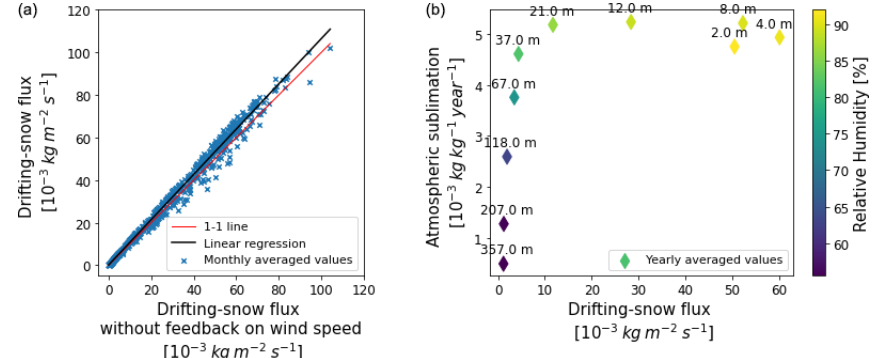
Figure 7. (a) Comparison between drifting-snow fluxes in the atmosphere calculated in MAR-DR using the usual wind speed values ( y axis) or using wind speed values retrieved from the MAR-nDR simulation ( x axis). The latter is done to approximate drifting-snow fluxes without accounting for the impact of drifting-snow sublimation on wind speeds. All fluxes are monthly averaged values over the 2010–2018 period computed at each of the 10 lowest model vertical levels. The black line denotes the best linear regression. Taking into account the atmospheric sublimation feedback on wind speed enhances drifting-snow fluxes. (b) Atmospheric sublimation as a function of drifting-snow fluxes for the 10 lowest model vertical levels. Values are averaged yearly to denote the model vertical level elevation (black text). Annual atmospheric sublimation rates are expressed in kilogram of sublimated snow mass per kilogram of moist air. The color bar indicates yearly averaged relative humidity at the considered level. Enhanced drifting-snow fluxes are responsible for increased atmospheric sublimation until a plateau is reached. This plateau coincides with the occurrence of near-saturated environments, where additional sublimation is limited by the negative feedback of